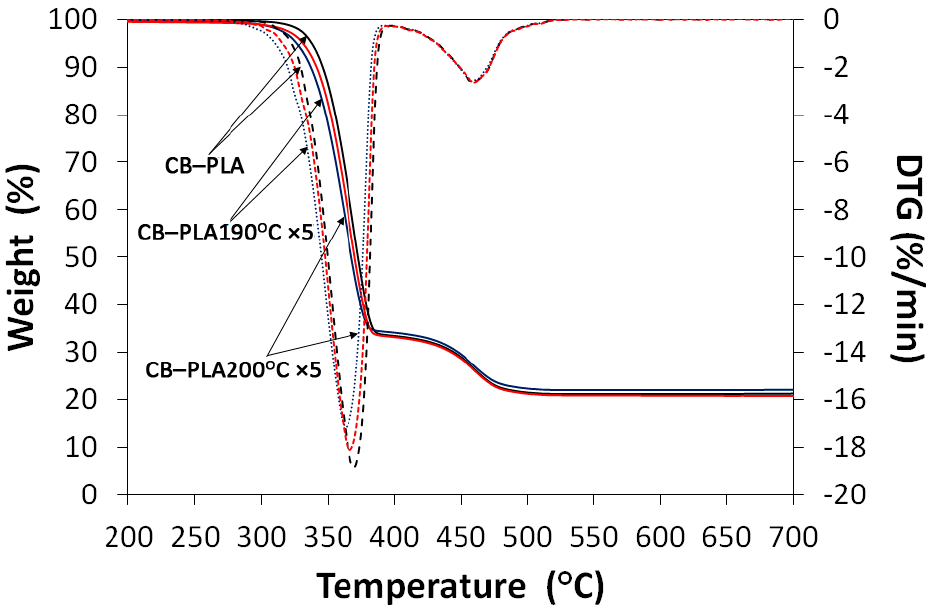
Figure 3. TGA and DTG curves for CB–PLA and CB–PLA ×5, reprocessed at 190 °C and 200 °C . Table 1. Decomposition temperatures as a function of weight losses, different maximum peaks and char residue determined for pure and recycled conductive PLA 3D filament .